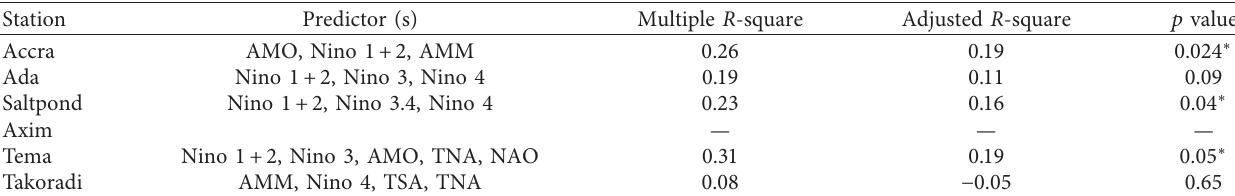
Table 7: Summary of stepwise regression results between JFM SPI and DJF climate